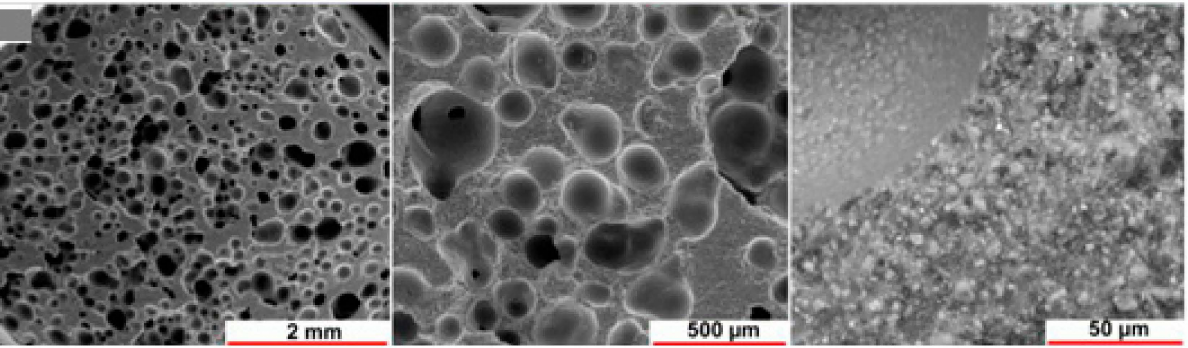
Figure 14. SEM micrographs at increasing magnifications of foamed geopolymer structures using H 2 O 2 at 4.5 vol% and heat-treated at 500 ◦ C for 1 h